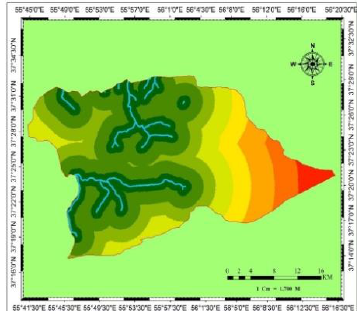
Figure 8. Map of the position of the rivers in the studied area